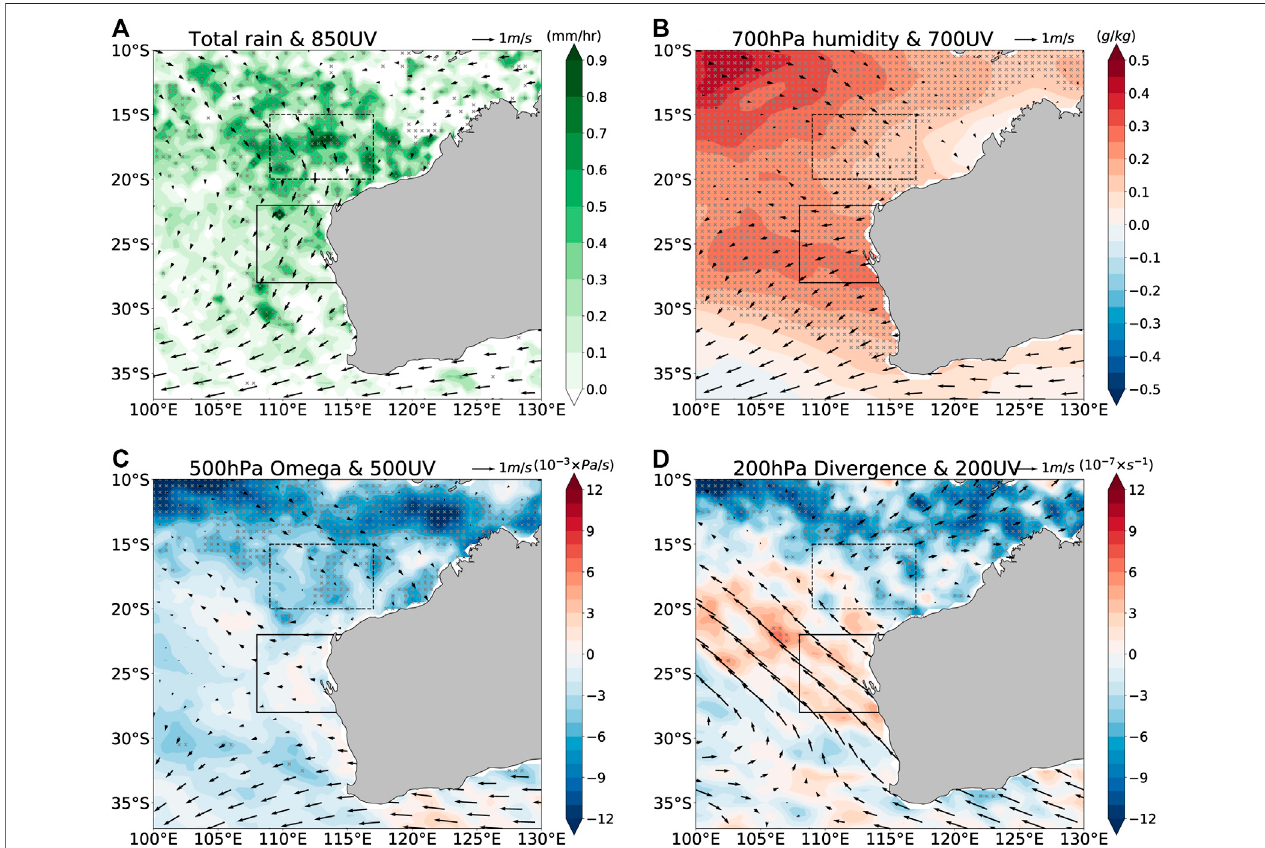
FIGURE4| Sameasin Figure3 butfor (A) precipitation(shading:mm hr − 1 )and850-hPawind(vector:m s − 1 ), (B) 700-hPaspeci fi chumidity(shading:g kg − 1 )and wind (vector: m s − 1 ), (C) 500-hPa vertical velocity (shading: 10 − 3 Pa s − 1 ) and wind (vector: m s − 1 ), (D) 200-hPa divergence (shading: 10 − 7 s − 1 ) and wind (vector: m s − 1 ) during 1981 – 2018 except precipitation during 1998 – 2013. The gray crosses indicate the variable anomalies above the 90% signi fi cance level by a Student t test. The solid and dashed boxes indicate the WA (108 ° E-coast, 28 – 22 ° S) and NWA (109 – 117 ° E, 20 – 15 ° S) coastal regions, respectively.